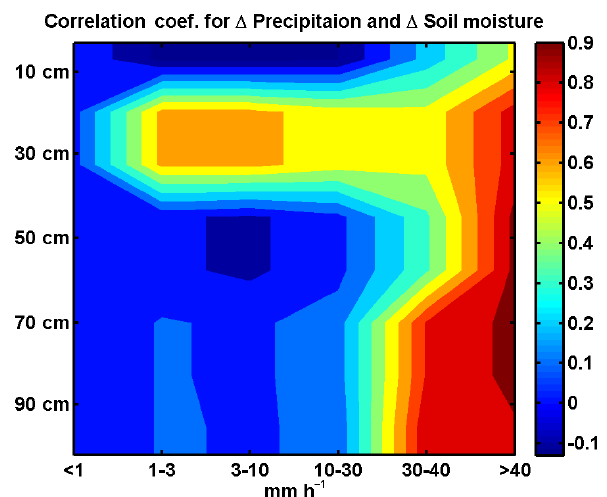
Figure 4. Correlation between hourly changes in precipitation and soil moisture at the Lien Hua Chih station in 2010. The ordinate is the soil depth and the abscissa is the rainfall intensity. Color shading indicates the correlation coefficient, with values shown in the color bar to the